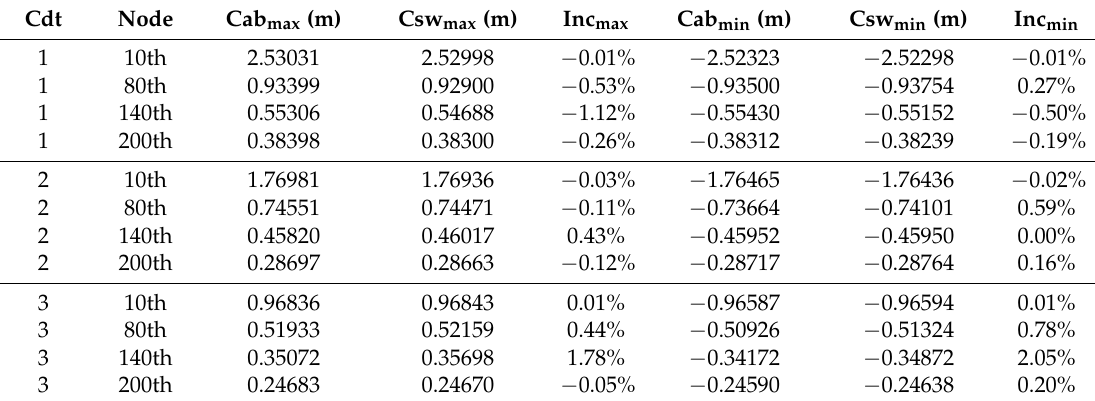
Table 7. Maximum, minimum and increase of node response.